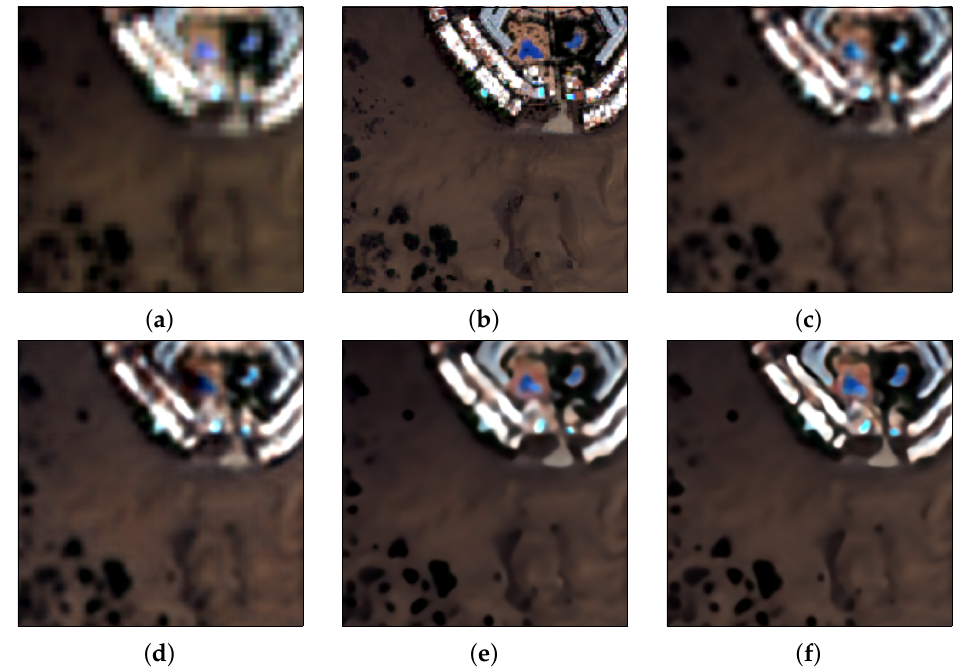
Figure 14. SR comparative performance between: ( a ) Sentinel-2 bicubic image; ( b ) WorldView-2 GT; ( c ) Dual_DeepLab model; ( d ) Dual_DeepLab_RRDB model; ( e ) RS-ESRGAN inference, ( f ) SEG- ESRGAN model. Image size 200 ×